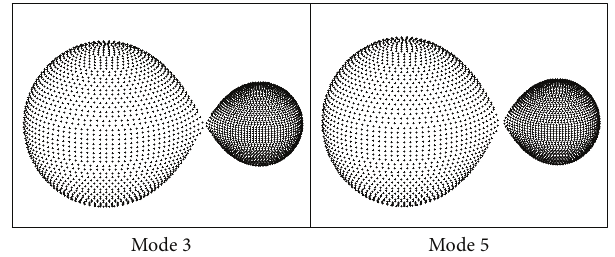
Figure 3: Geometrical structure of V921 Her at phase 0.25.